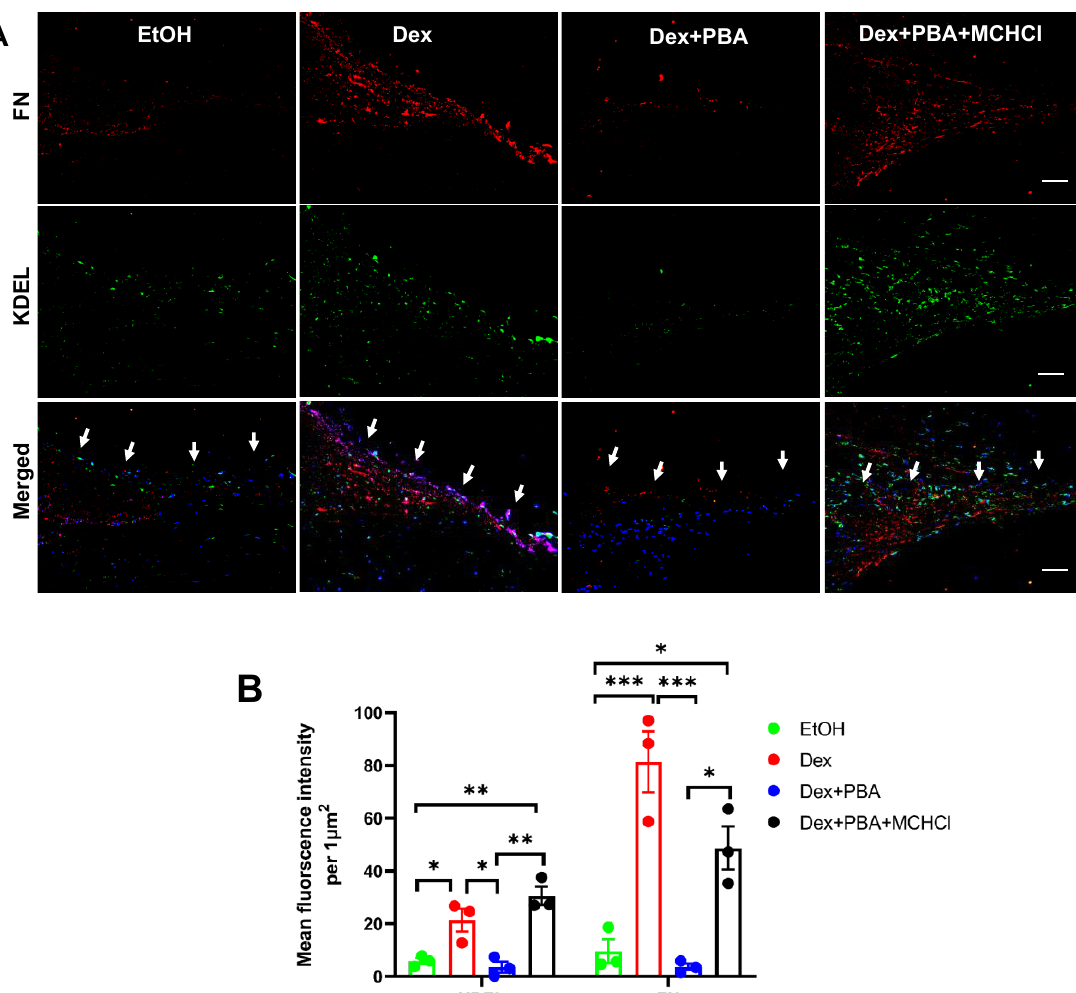
Figure 8. Effect of PBA on Dex induced ECM deposition and ER stress in ex vivo cultured human corneoscleral segment tissue: Human corneoscleral segments with an intact TM rim were dissected into four equal quadrants and each quadrant was cultured and treated with either ethanol or Dex (100 nM) or Dex + PBA (5 mM) or Dex + PBA + MCHCl (200 µM) for 7 d. Immunostaining ( A ) and densitometric analysis of ( B ) FN and KDEL on ex vivo cultured human corneoscleral segments. ( n = 3, ONE WAY ANOVA with multiple comparison, * indicates p < 0.05, ** indicates p < 0.001, *** indicates p < 0.0001, scale bar 50 µm, the white arrow represents the TM region).